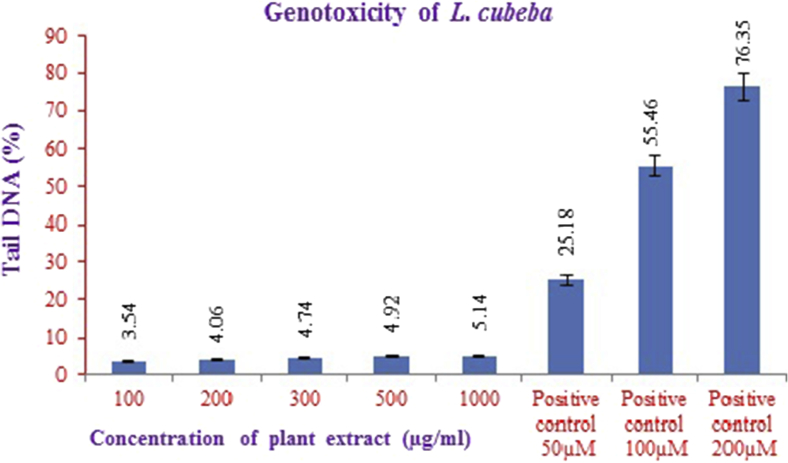
Genotoxicity of L. cubeba and H2O2 (positive control).